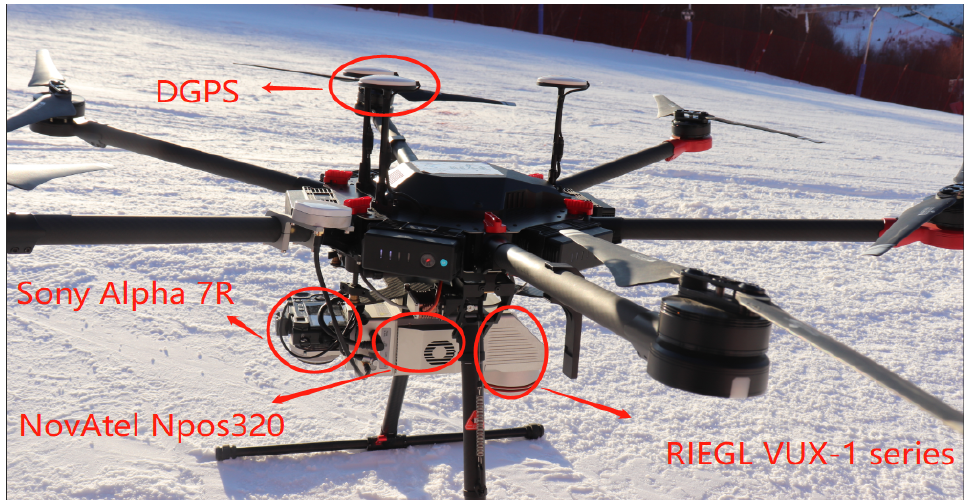
Figure 2. Structure diagram of point cloud acquisition system, mainly including inertial navigation, DGPS, camera, and laser scanning.